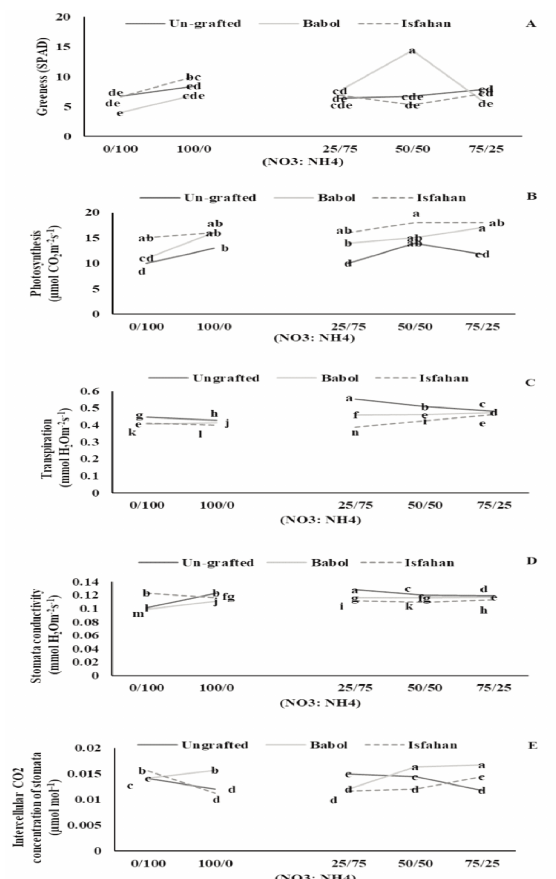
Fig. 4 ­ The interaction effect of different rootstocks and NO :NH ratio on A) Greenness (SPAD), B) photosynthe­ 3 4 sis, C) transpiration D) stomata conductivity, and E) inter­ concentration of cellular CO 2